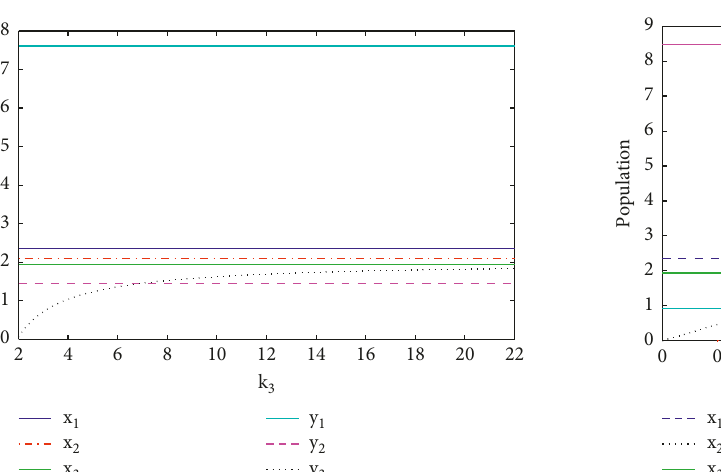
Figure 8: Effect of m